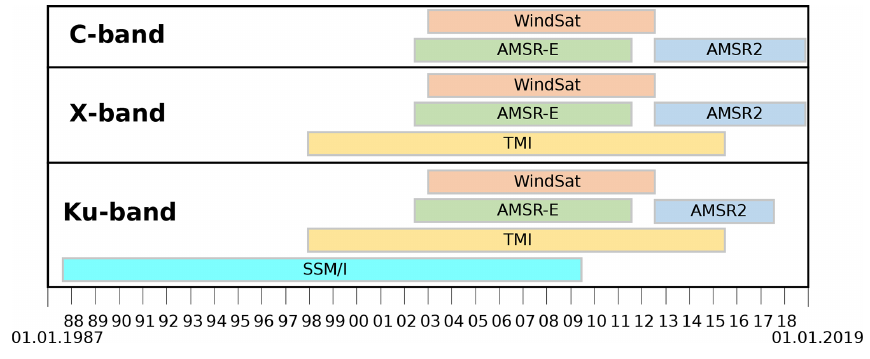
Figure 1. Time periods of the sensors used for each